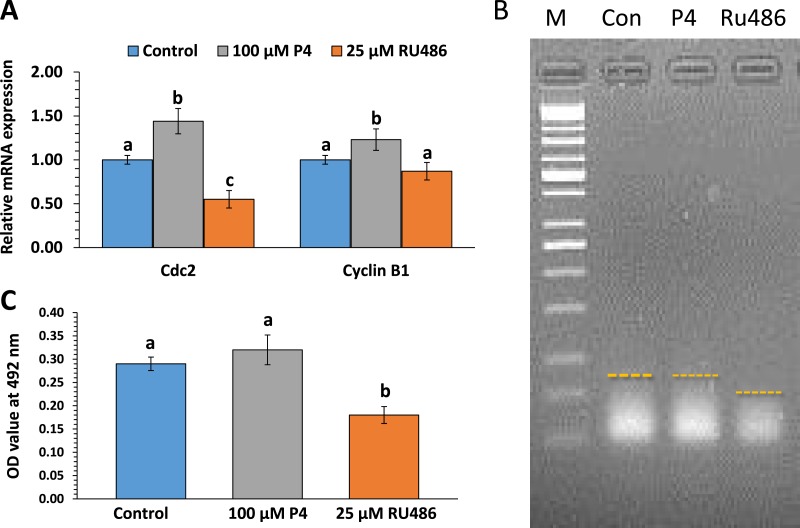
The effects of P4 or RU486 on maternal gene expression, polyadenylation levels and p34cdc2 kinase activity.Maternal mRNA expression at the MII stage (A). Analysis of poly(A) tail length of Cdc2 transcripts at the MII stage (B). Treatment with 100 µM P4 or 25 µM RU486 are indicated at the top of the figure. Oocytes at the MII stage (44 h). Differences in poly(A) tail lengths of maternal mRNA represented by PCR smears are indicated by dotted lines. MPF activity in MII oocytes (C). MPF was isolated from oocytes treated with 100 µM P4 or 25 µM RU486. Data are expressed as the percentage ± SEM of three independent replicates of three experiments. Different superscripted letters show significance (p < 0.05).